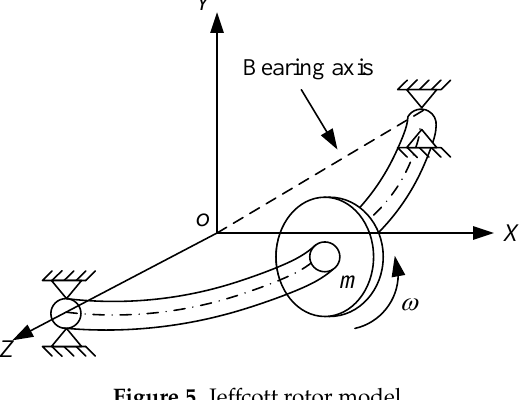
e Figure 7. Model of a rotating coil.